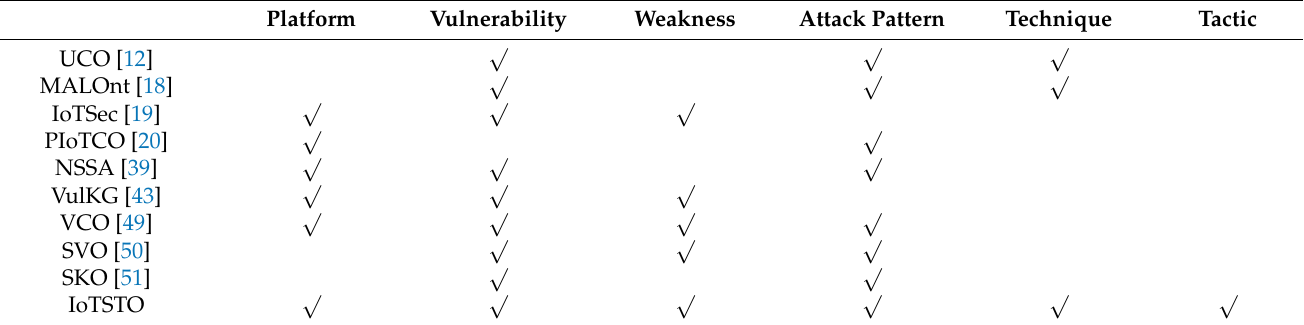
Table 3. Knowledge domain scope of several related cybersecurity ontology models.